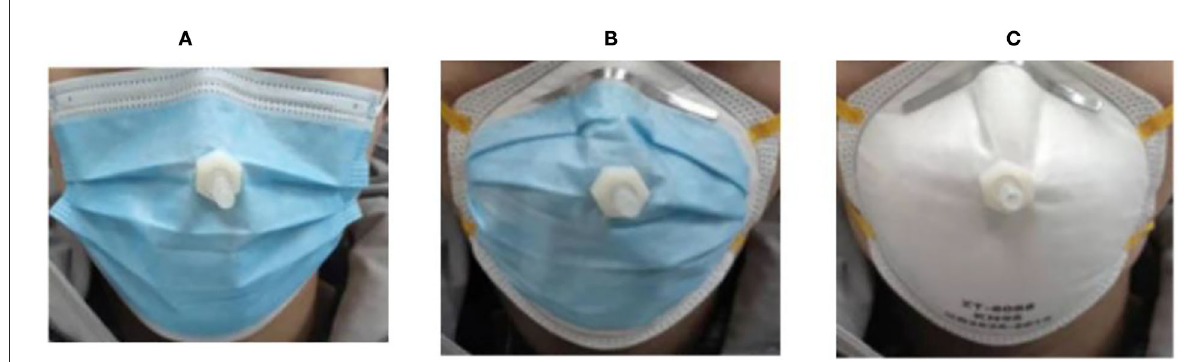
FIGURE1 Three types of face masks: (A) modified face mask, (B) N95 face mask, and (C) surgical face mask (62).